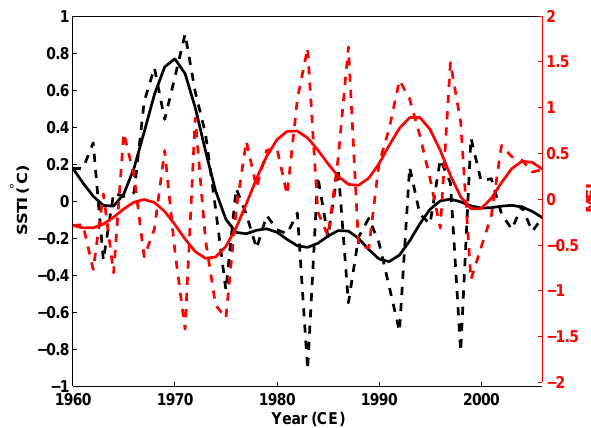
Fig. 9. Comparison of filtered (black) and unfiltered (black dash) SST index (mean removed) off Peru upwelling region with filtered (red) and unfiltered (red dash) Multivariate ENSO Index (MEI; Wolter and Timlin,